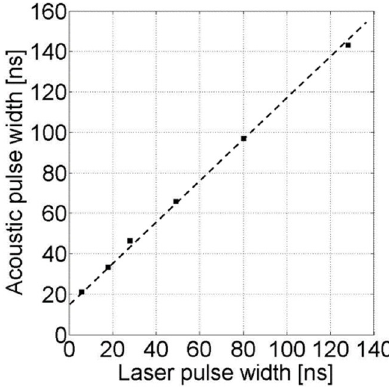
Figure 5. Acoustic pulse widths measured by PES for incident laser pulse widths from 6 to 130 ns.